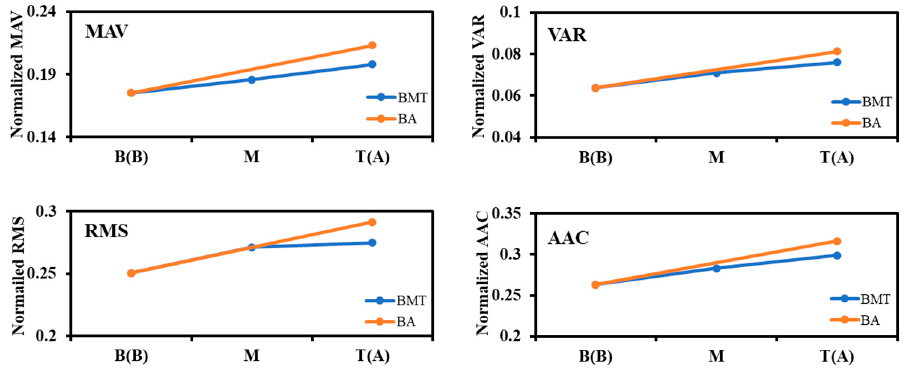
Figure 4. Comparison of the exercise experiment results of the present study with our previous research [20].